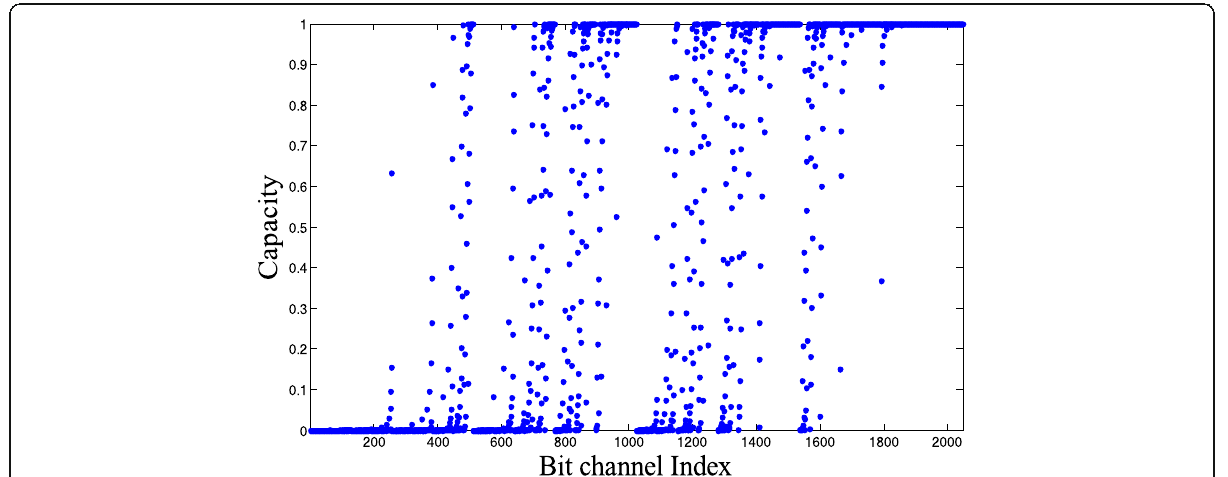
Fig. 6 The capacity of bit channel at N = 2048: The capacity of binary erasure channels (BEC) when the code length N is